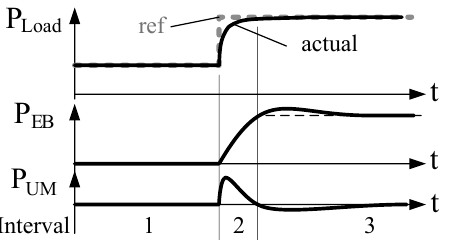
Figure 12. Control operation intervals upon sudden load